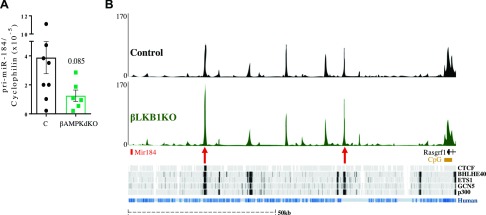
AMPK may mediate miR-184 expression at the transcriptional level. A) Pri-miR-184 expression was measured by RT-qPCR in isolated islets from βAMPKdKO (green) and littermate control (C, black) mice. B) Integration of ATAC-seq enrichment profiles with ENCODE CTCF and transcription factors ChIP-seq datasets. Sequencing tracks for the ∼100-kb genomic region upstream miR-184 show 2 enriched ATAC-seq peaks (red arrows) in βLKB1KO (green) vs. control (black) islets. CTCF ChIP-seq profiles in liver show enrichment of this factor within the most proximal ATAC-seq differential peak. Binding enrichment of other transcriptional regulators (CH12 cells) is observed at both differential ATAC-seq peaks. Alignment with the human DNA track is presented in blue.